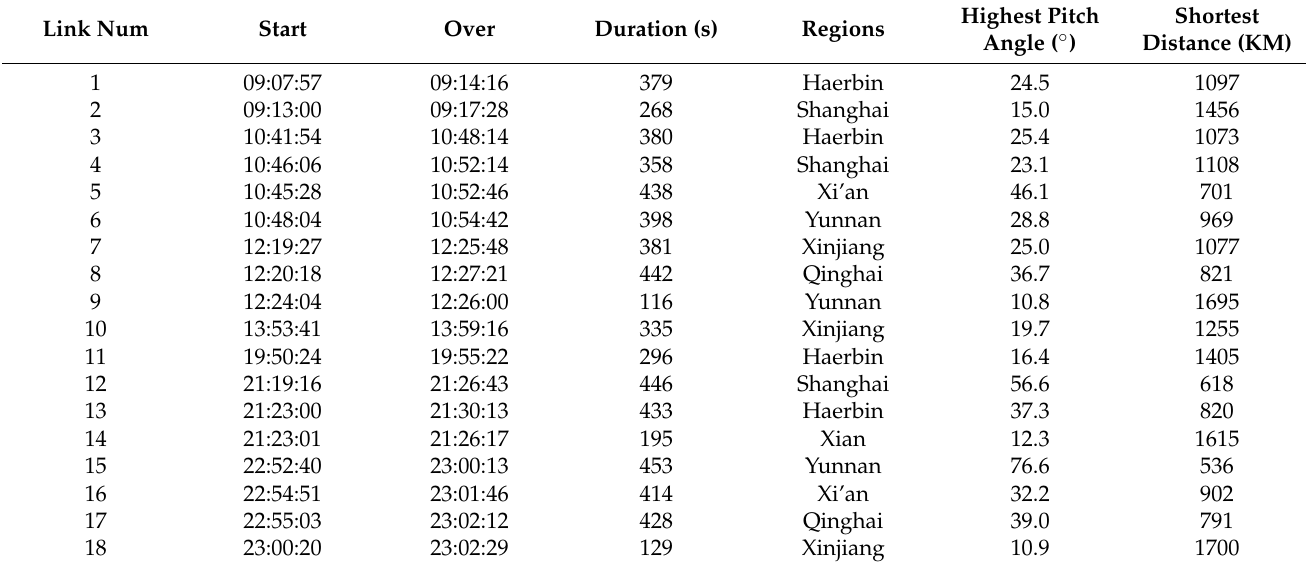
Table 7. Link status in 24 h.